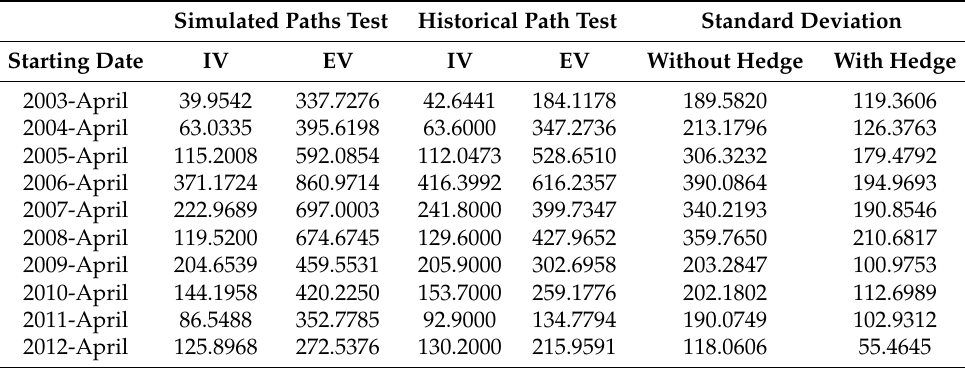
Table 5. Fast gas storage valuation (under spot model 2 (19)), in million of US dollars.